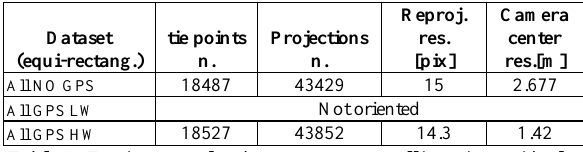
Table 7. Equirectangular dataset: stats on collinearity residuals.